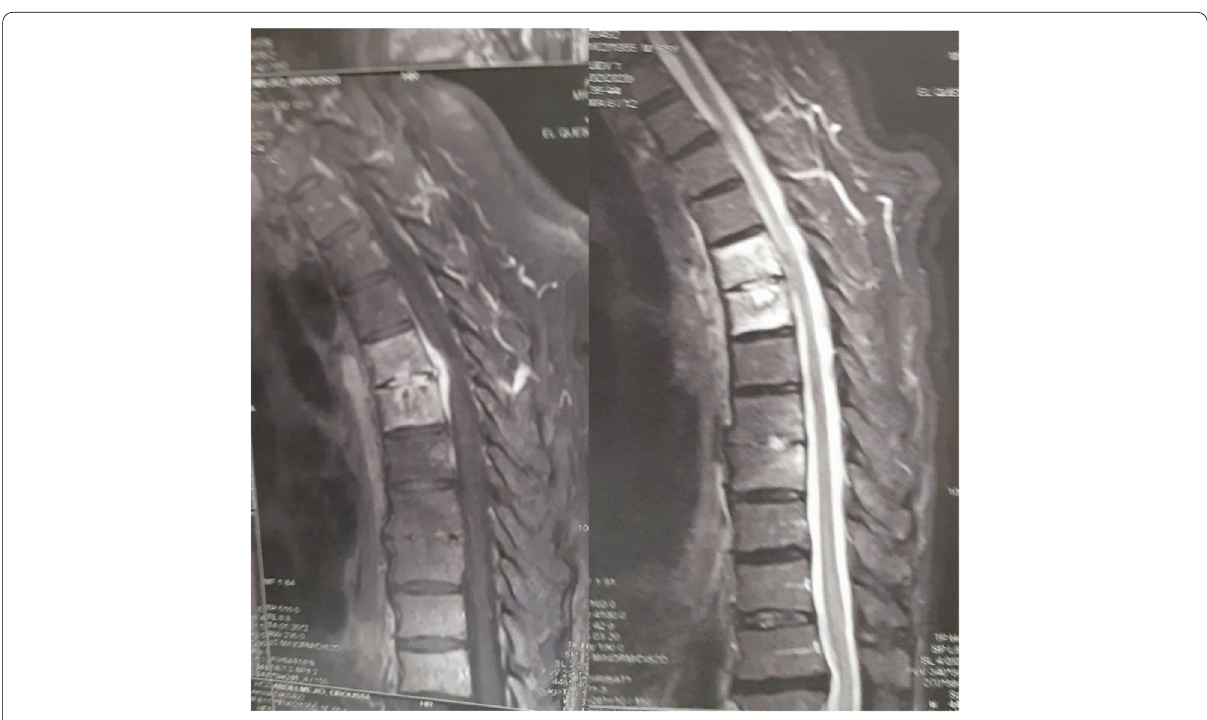
Fig. 4 MRI of the dorsal spine with aggravation of hypersignal T5–T6 and development of a primary epidural